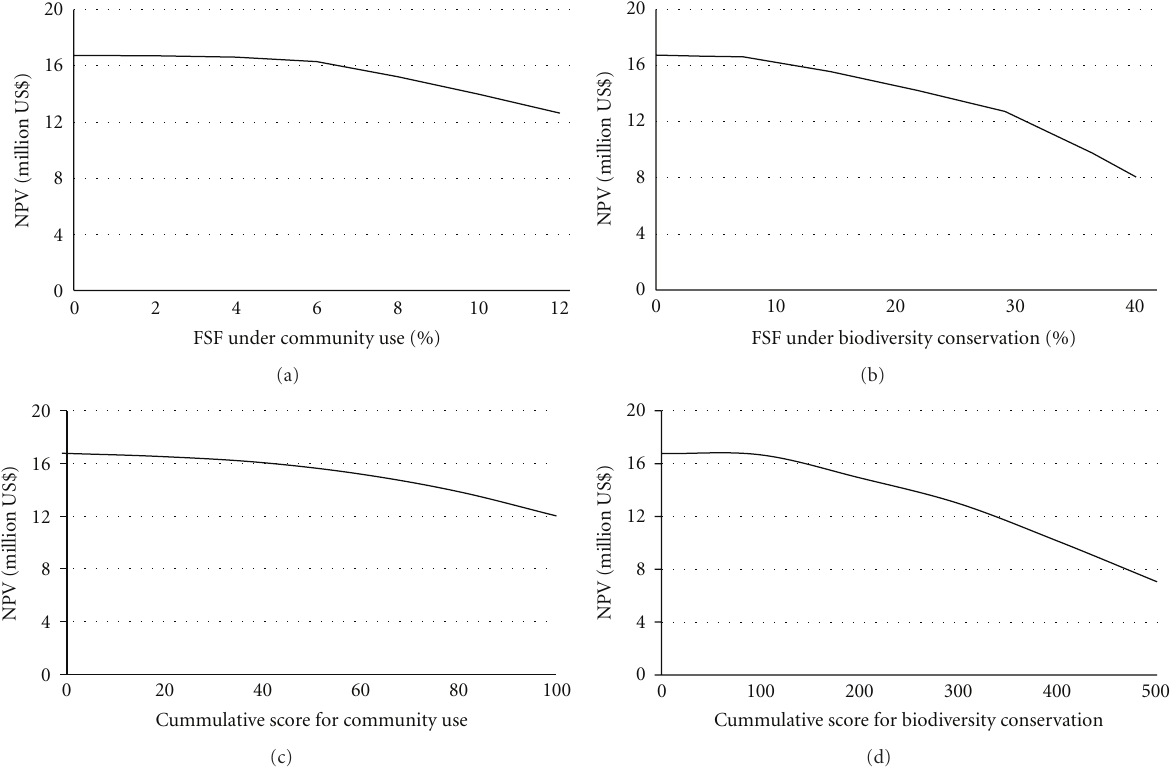
Figure 5: Production possibility frontiers for logging and livelihood systems (a) and logging and biodiversity conservation (b), assuming stands are weighted equally for nonlogging land uses within Faro State Forest; production possibility frontiers considering di ff erent weights among stands for nonlogging land uses, for logging and livelihood systems (c), and logging and biodiversity conservation (d). Harvests are assumed to be performed from current logging